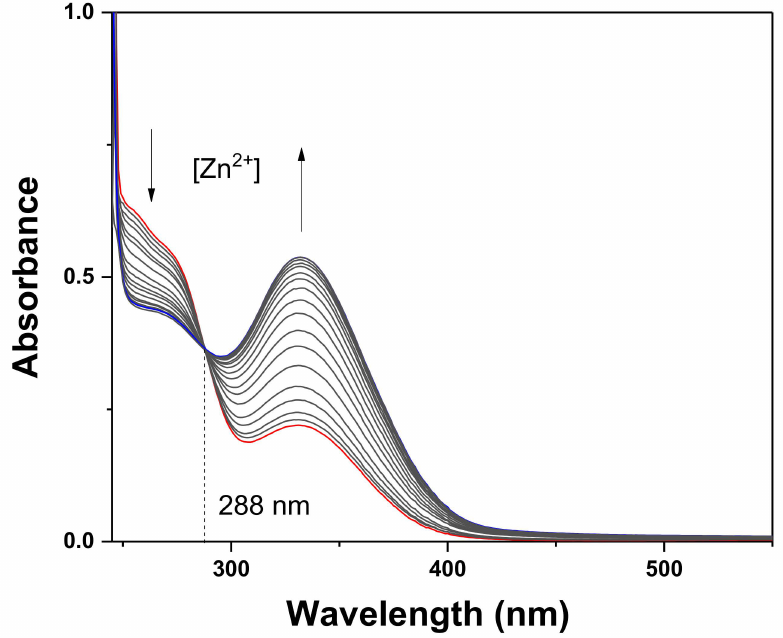
Figure 3. Absorption variations of TCC (4.0 × 10 − 5 M) with varied concentrations of Zn 2+ . As indicated by the arrow, the absorption of 270 nm gradually decreased with the increasing Zn 2+ (0, 4, 8, 12, 16, 20, 24, 28, 32, 36, 40, 44, 48, 52, 56, 60, 64 and 68 µ M), while the absorption of 340 nm increased. A Job plot was employed to apprehend the association ratio of TCC for Zn 2+ (Figure 4). The greatest fluorescence emission at 450 nm appeared at a molar fraction of 0.7, which means that TCC and Zn 2+ formed a complex with a 2:1 association ratio. The ratio was also proven by ESI-MS (Figure S5). The peak of 725.82 ( m/z ) corresponded to [2 · TCC − H + + Zn 2+ + MeCN] + (calculated m/z = 725.94) in the positive-ion